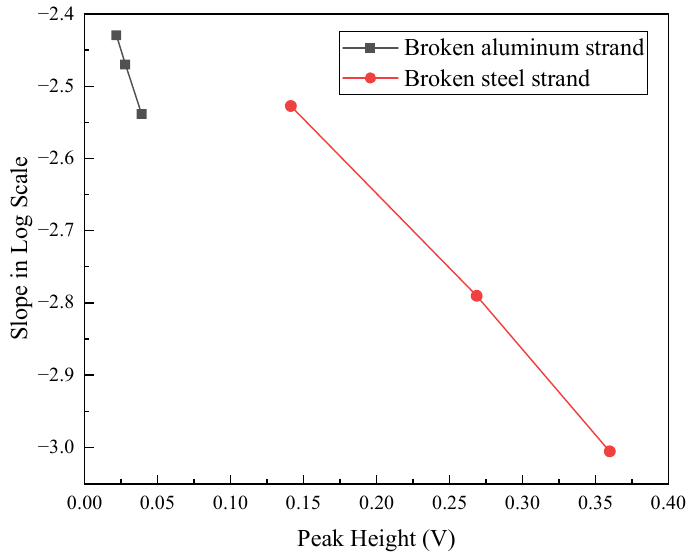
Figure 13. Defect classification recognition using peak height and slop in the log scale.